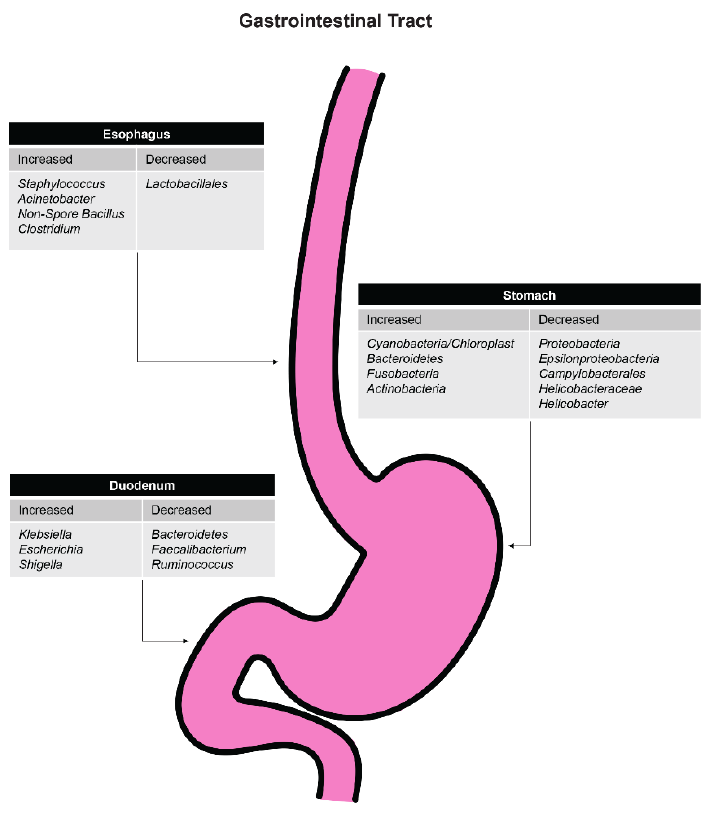
Figure 2. Effects of antibiotics on organism levels in various aspects of the upper gastrointestinal tract.